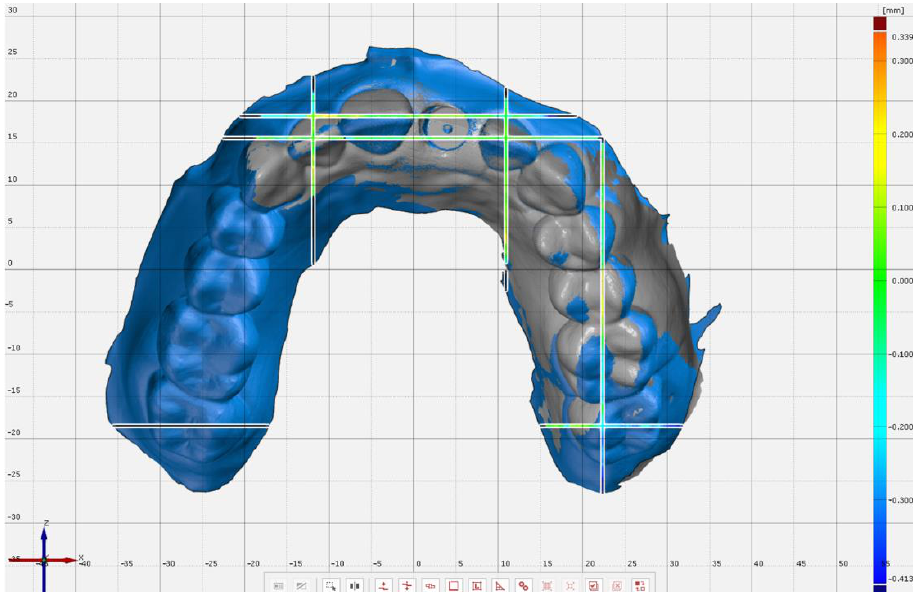
Figure 4. Measurement points (Left 2nd molar: Buccal, palatal, and distal gingival margins, mesiopalatal and distopalatal cusp tips, and most buccal point of the tooth. Left lateral incisor: Buccal, palatal, and mesial gingival margins, most mesial and incisal point of the tooth. Right central incisor: Mesial gingival margin and most mesial point of the tooth. Right lateral incisor: Buccal and gingival margins and most incisal point of the tooth) on partial-arch scan at selected planes when superimposed to the reference scan.